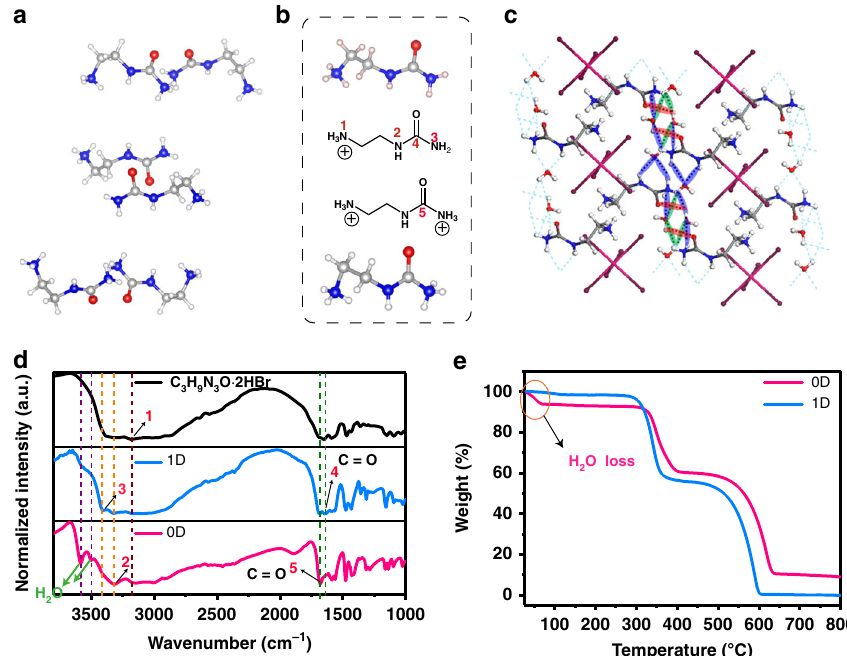
Fig. 2 Characterization of hydrogen bonds in crystals of 1D and 0D lead bromide hybrids. a Organic cations in the 1D lead bromide crystal. b Spatial con fi guration of C 3 N 3 H 11 O 2 + and C 3 N 3 H 10 O + with functional groups being marked. c Highlights of the hydrogen bonds between organic cations and water in the 0D lead bromide crystal. d Infrared spectroscopy (IR) analysis of abrasive 1D and 0D crystals. e Thermogravimetric analysis (TGA) for weight loss curves of 1D and 0D crystals